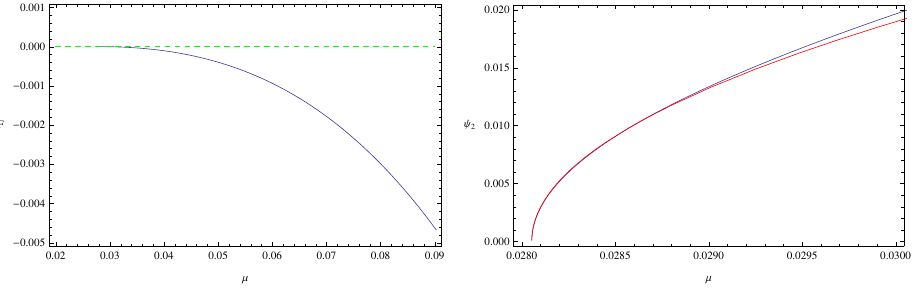
Figure 2 . (Color online) We plot the free energy as a function of chemical potential in the left panel with q = 100, m 2 = − 2, C 4 = 0 and the right panel is with behaviors of ψ 2 . The solid blue line represents boson star phases and the solid red line corresponds to ψ 2 ≈ 0 . 430( µ − µ c ) 1 / 2 with µ c = 0 . 02806. In addition, the dashed line of F = 0 in the left panel shows the free energy of the flat